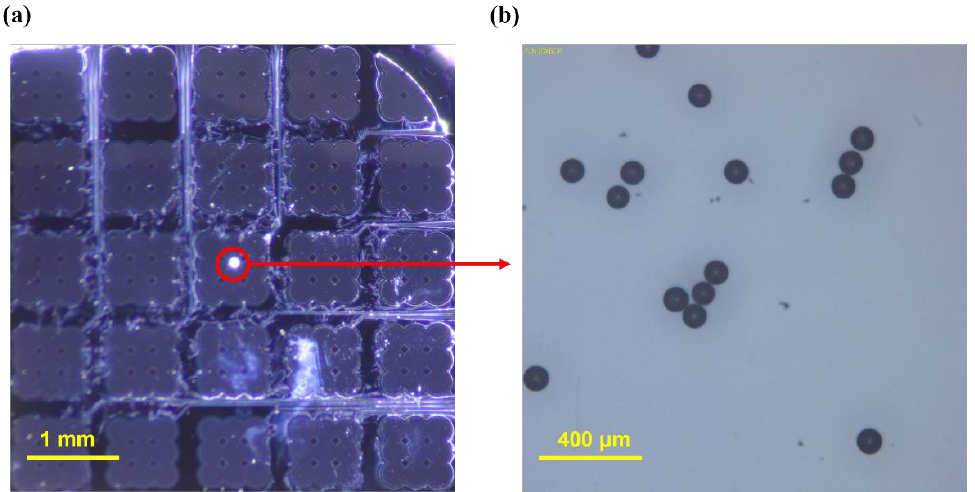
Figure 5. ( a ) Photograph of the floating particle captured via the device; ( b ) microscopic photograph of polyethylene